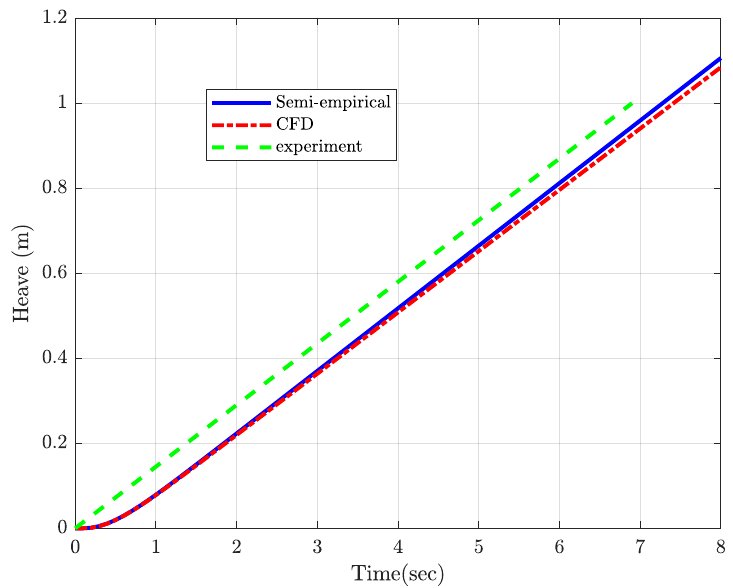
Figure 9. Heave response (developed with MATLAB [67]).